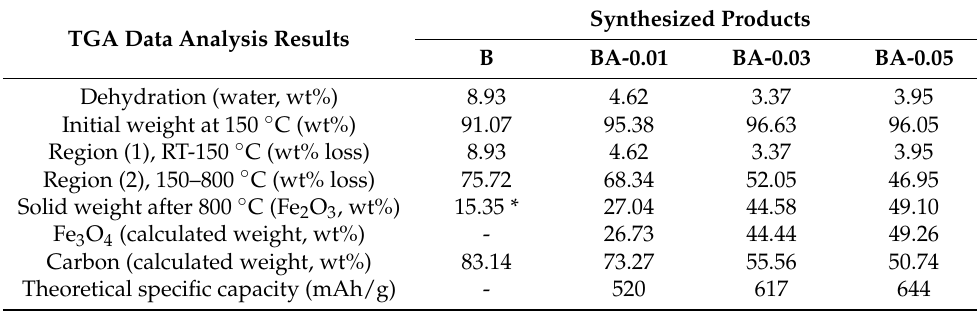
Table 1. The results of TGA data analysis for content determination and theoretical specific capac- ity